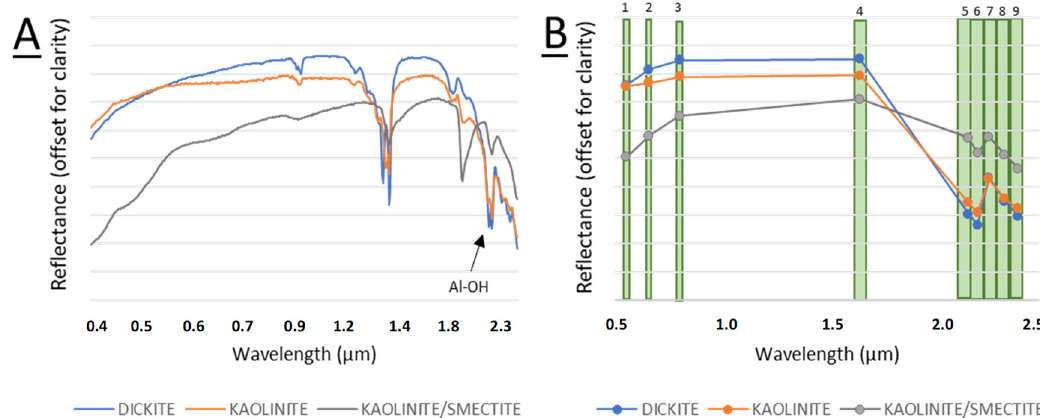
Figure 3. ( A ) USGS spectral signatures of the selected minerals used in this study [45]; ( B ) the resampled spectra according to the 9 VNIR and SWIR bands of the ASTER data.